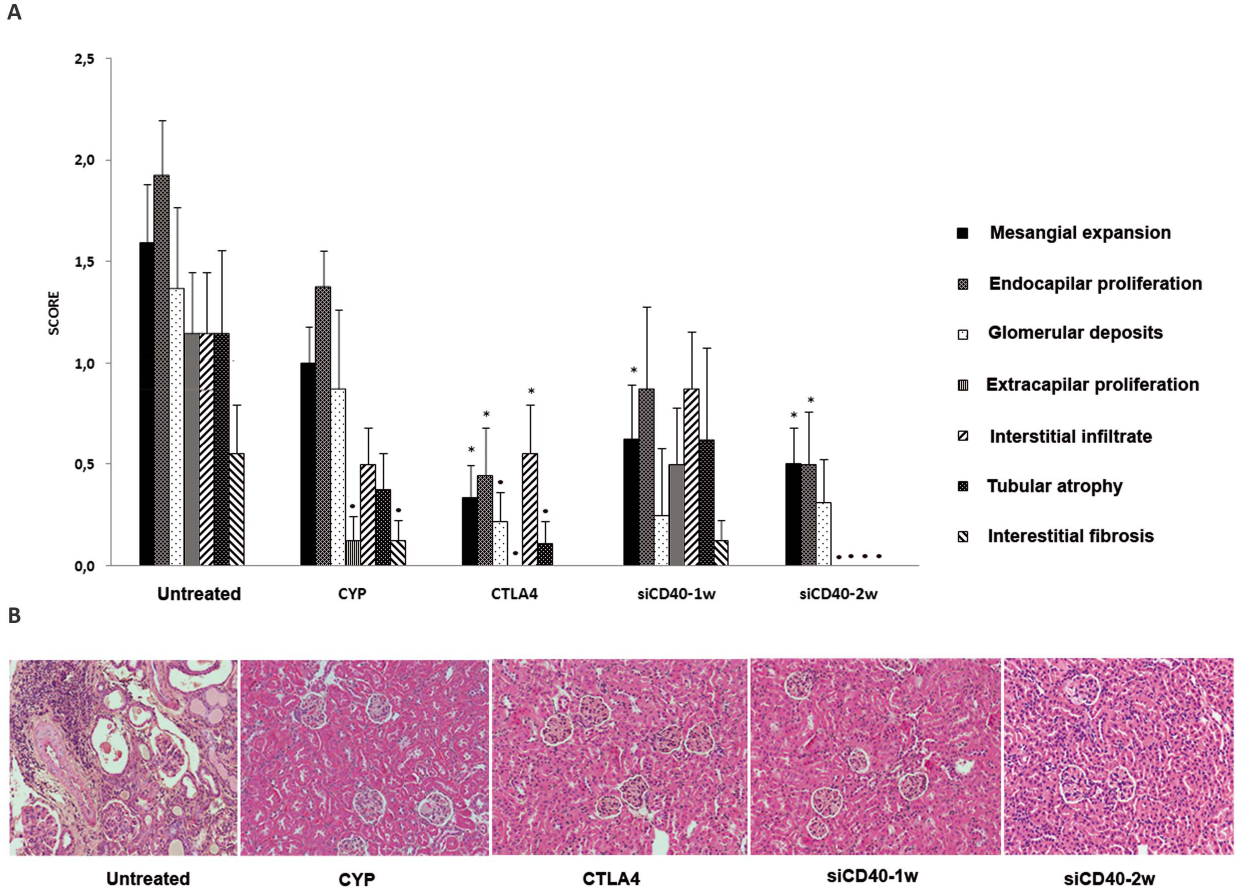
Figure 4. Renal histopathology. A) Costimulatory blockade reduced the elementary histological lesions of lupus nephritis. B) Representative photomicrograph (x200) of renal histology for each group. Data are expressed as mean 6 SEM *p , 0.05 vs untreated, p , 0.01 vs untreated.